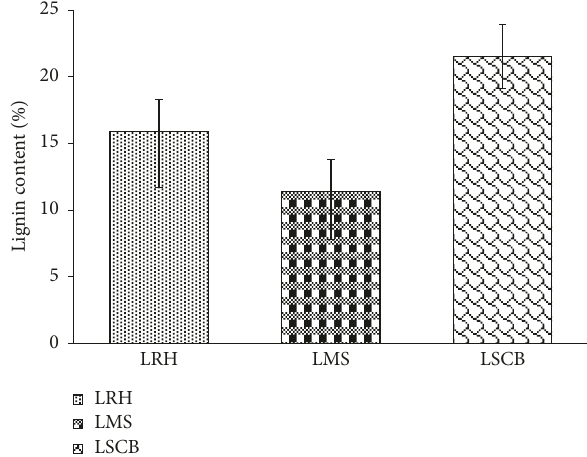
Figure 1: Lignin content in crop